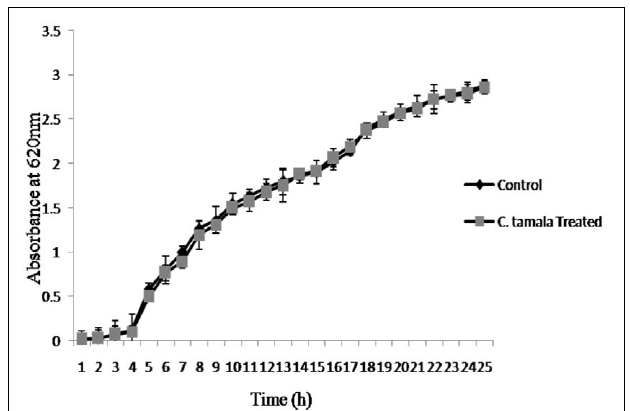
TABLE 1 | The chemical composition of essential oil extracted from Cinnamomum tamala .